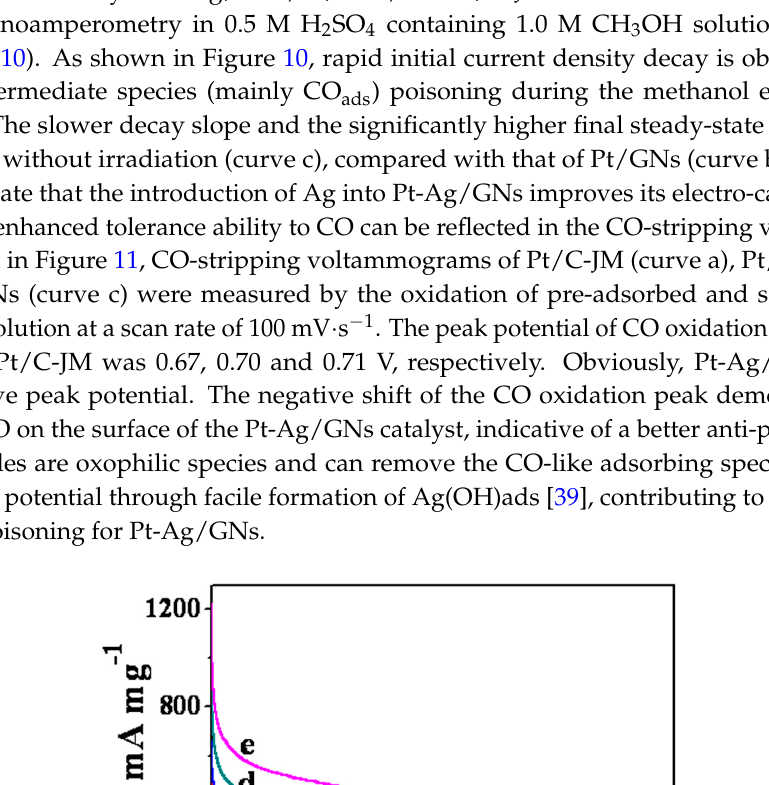
Figure 9. Photocurrent responses of Pt-Ag/GNs: (a) under dark; (b) under intermittent visible irradiation (every 10 s); (c) under intermittent UV irradiation (every 10 s). The catalytic stability of Pt ‐ Ag/GNs, Pt/GNs, and Pt/C ‐ JM for methanol oxidation was further